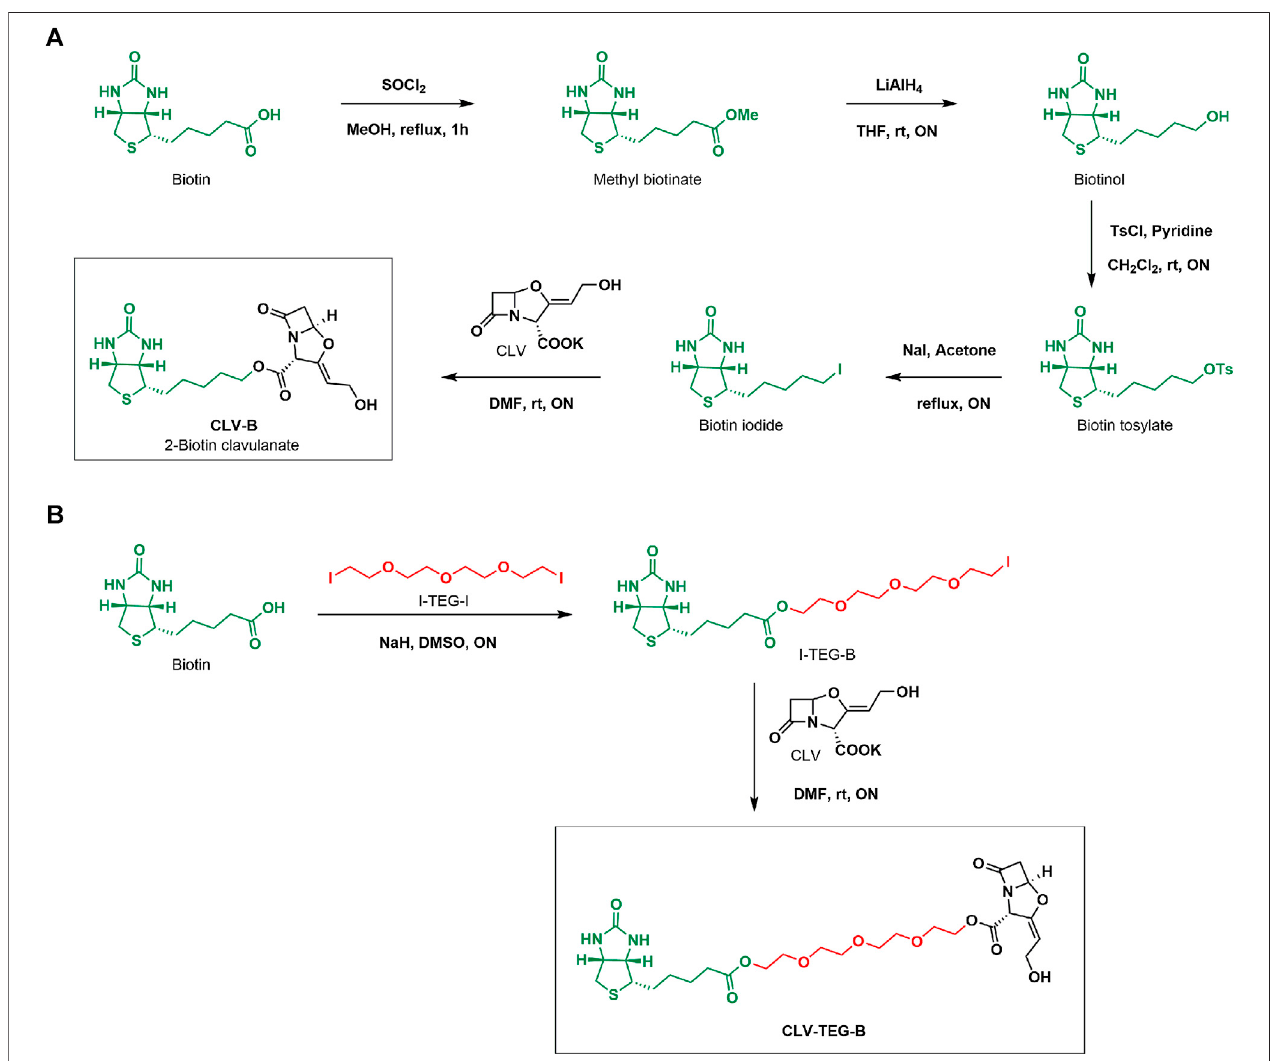
FIGURE 1 | Synthesis of biotinylated derivatives of clavulanic acid (CLV). (A) CLV-B and (B) CLV-TEG-B. CH 2 Cl 2 , dichloromethane; DMF, dimethylformamide; DMSO, dimethyl sulfoxide; LiAlH 4 , lithium aluminum hydride; MeOH, methanol; NaI, sodium hydride; ON, overnight; rt, room temperature; SOCl 2 , thionyl chloride; THF, tetrahydrofurane; TsCl, tosyl